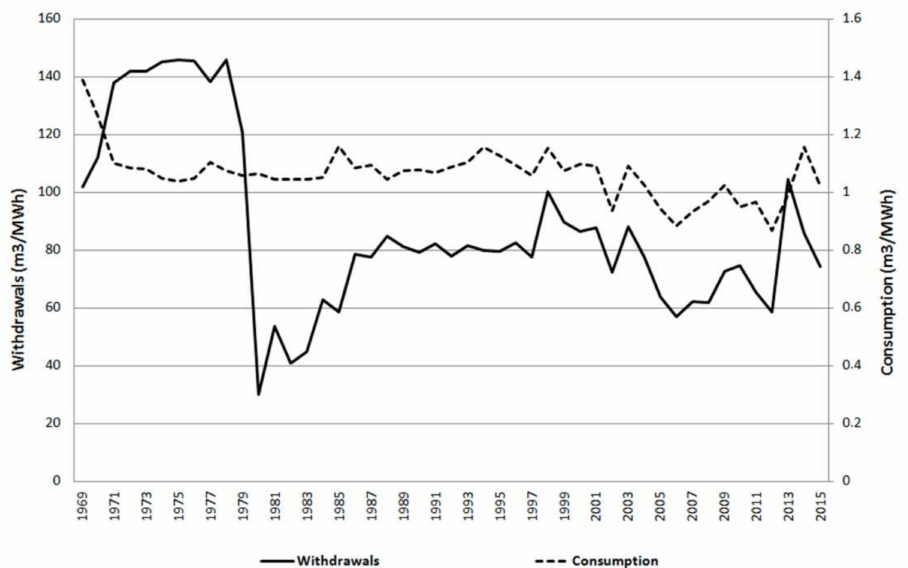
Figure 5. Evolution of technological water intensity in terms of water withdrawals (left axis) and water consumption (right axis) of thermal power stations in the Ebro River basin, 1969–2015. Note: The Escucha and Castelnou coal-fired power stations-using air-cooled condensers-are excluded. Source: own design (see ’Data File S1’ in Supplementary Materials).